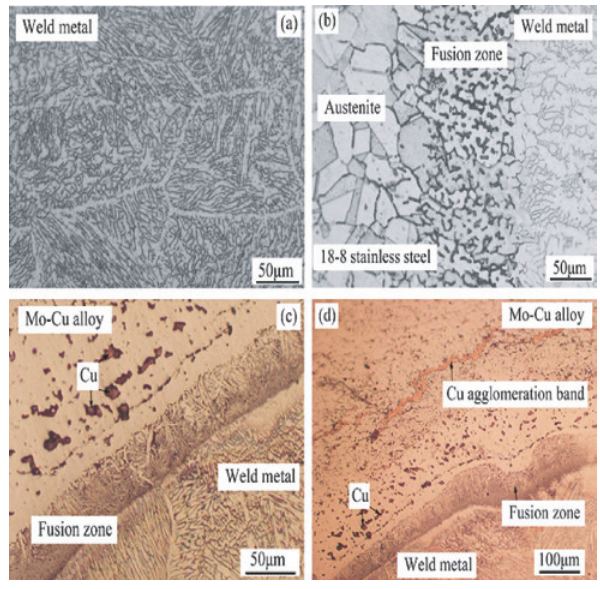
Fig. 2: Microstructure features of: (a) weld metal, (b) fusion zone near 18-8 stainless steel, (c) fusion zone near Mo-Cu composite and (d) Cu agglomeration regions in Mo-Cu composite HAZ